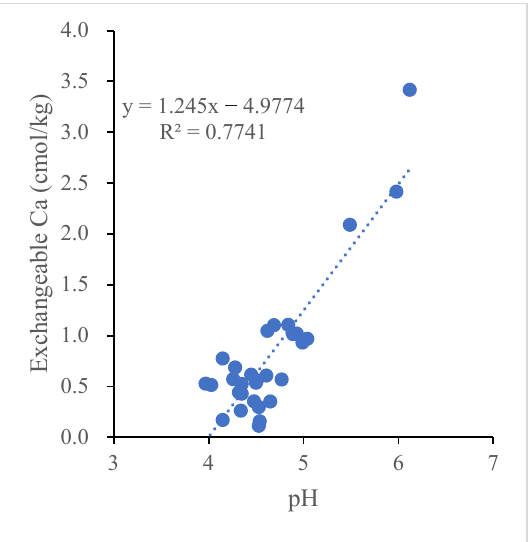
Figure 5. The correlation between the pH and exchangeable Ca in bayberry soils. Each dot represents a soil sample in the figure.